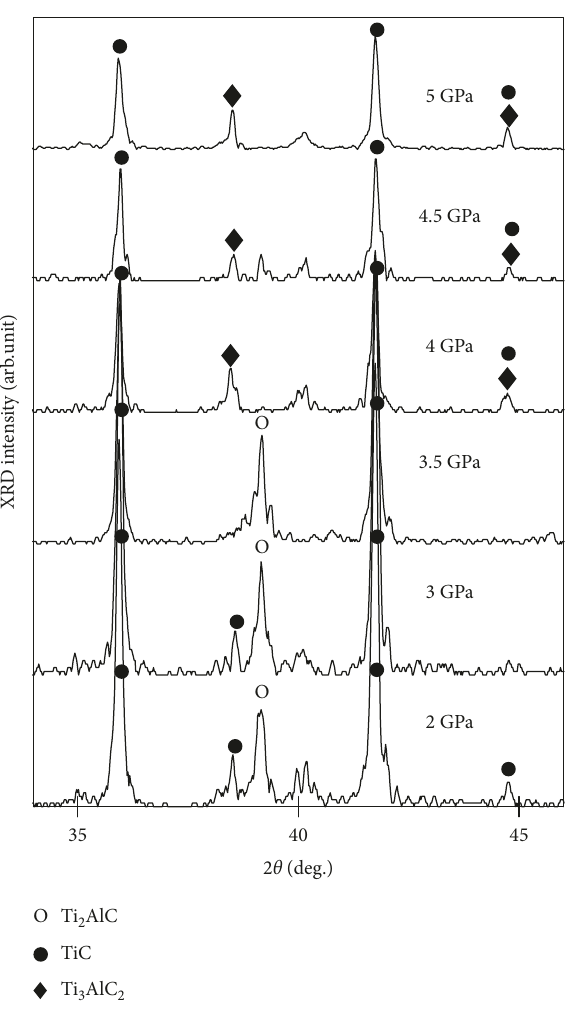
Figure 2: XRD patterns of synthetic samples synthesized under 2 ∼ 5GPa and 950 ° C for